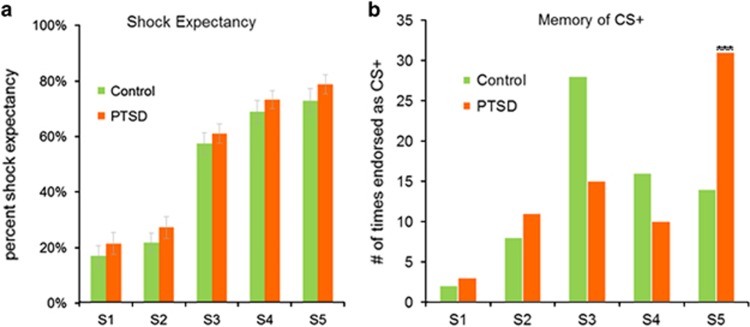
Shock expectancy and post-generalization memory of fear association. (a) Subjects provided ratings during the generalization task indicating the expectation of receiving a shock with each stimulus (S1–S5). There was no significant difference in shock expectancy between the PTSD and control groups (F9,53=1.5; P>0.2) nor any fear-level × diagnosis interaction (F9,53=0.47; P>0.7). As expected, there was a strong main effect of stimulus-intensity (F9,53=38.25; P<0.0001). Error bars indicate standard error of the mean. (b) The memory of fear association exhibits generalization in PTSD with a bias toward the face expressing the greatest fear (S5). The PTSD group misidentified the S5 stimulus as the CS+ (χ21=10.19; P=0.001) more frequently (count=31; 45.2%) than the control group (count=14; 20.6%). The control group correctly identified the S3 as CS+ (count=28; 41.2%) more frequently than the PTSD group (count=15; 21.4%). There were no between-group differences for S4 (χ21=0.09; P=0.76) or S2 (χ21=2.86; P=0.10). The y axis represents count data (two per subject) and therefore does not have standard error bars. CS, conditioned stimulus; PTSD, posttraumatic stress disorder.